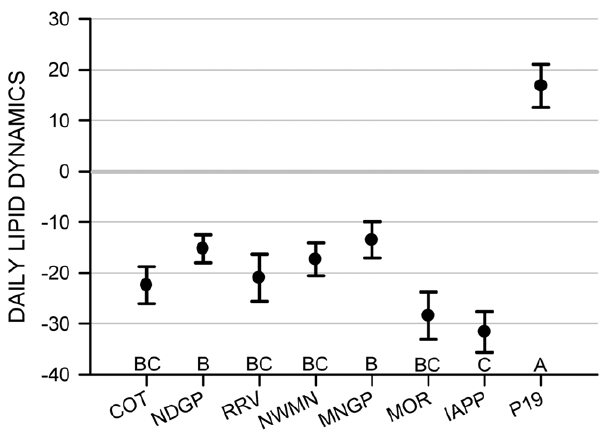
Figure 2. Mean daily lipid dynamics (DLD ± SE) of female lesser scaup in the upper Midwest. Least-square mean daily lipid dynamics (DLD 6 SE) of female lesser scaup (n=483) collected from stopover sites during spring migration 2004 and 2005 by regions (COT = ND Missouri Coteau, NDGP = ND Glaciated Plains, RRV = Red River Valley of MN and ND, NWMN = Northwestern MN, MNGP = MN Glaciated Plains, MOR = MN Morainal, IA = IA Prairie Pothole, and P19 = Pool 19). Capital letters are Tukey-Kramer adjusted mean grouping at P , 0.05. DLD values . 0 indicate lipid storage while those , 0 indicate lipid catabolism.